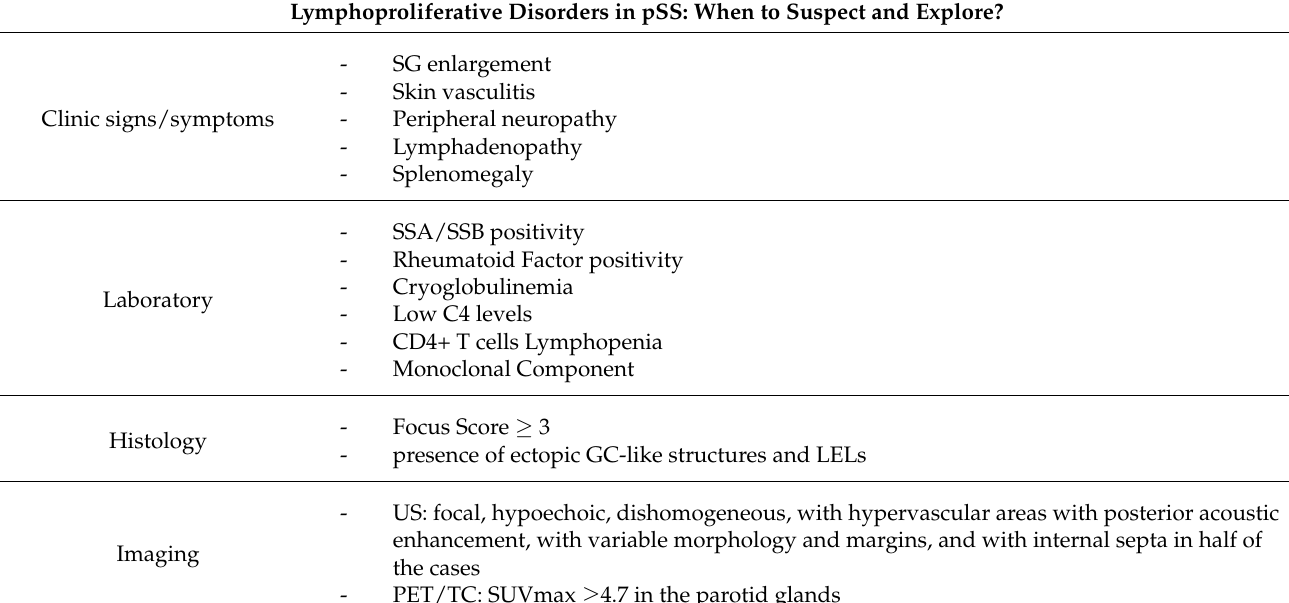
Table 1. Clinical, laboratory, histological and imaging features to evaluate when assessing lymphoproliferative risk in pSS. Lymphoproliferative Disorders in pSS: When to Suspect and Explore?